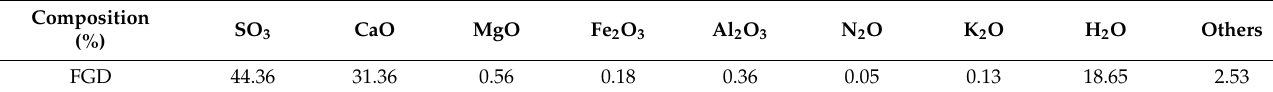
Chemical composition (by mass %) of FGD gypsum. Table 1.